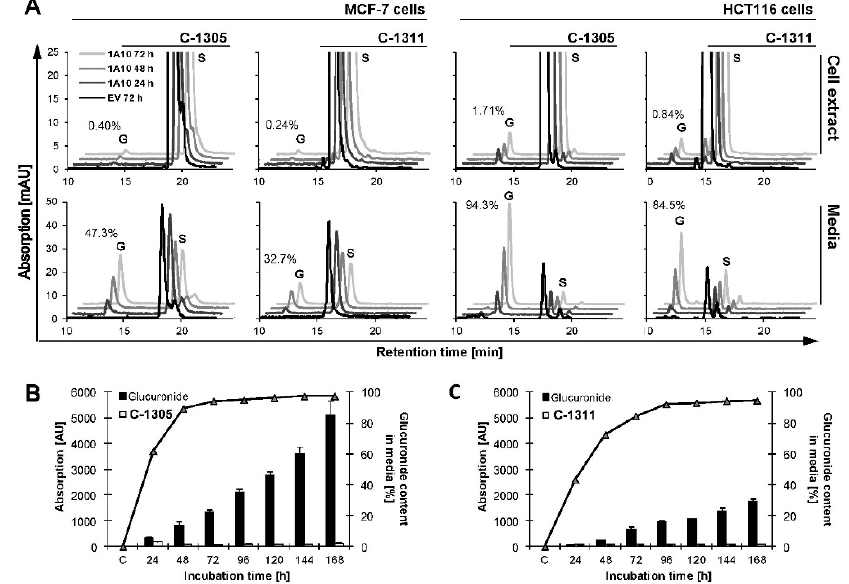
Figure 3. Metabolic transformation of C-1305 and C-1311 compounds in MCF-7 and HCT116 cells. ( A ) MCF-7-EV, MCF-7-UGT1A10, HCT116-EV and HCT116-UGT1A10 cells were treated with 30 mM C-